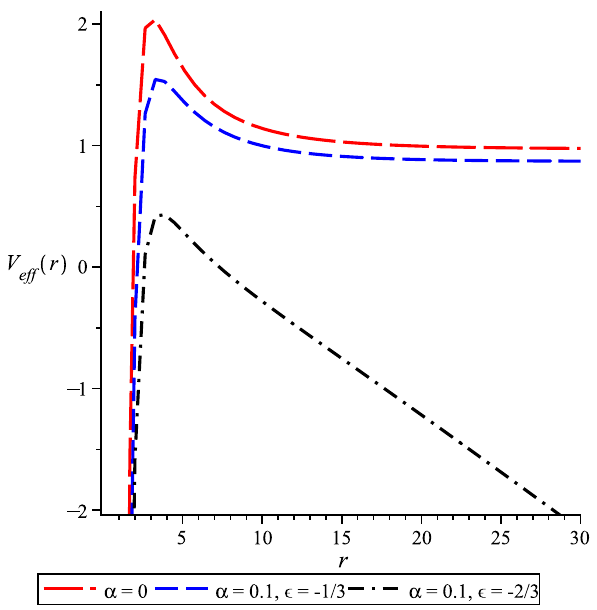
Fig. 2 The effective potential with M = 1 , Q = 0 . 5 , L = 6 .